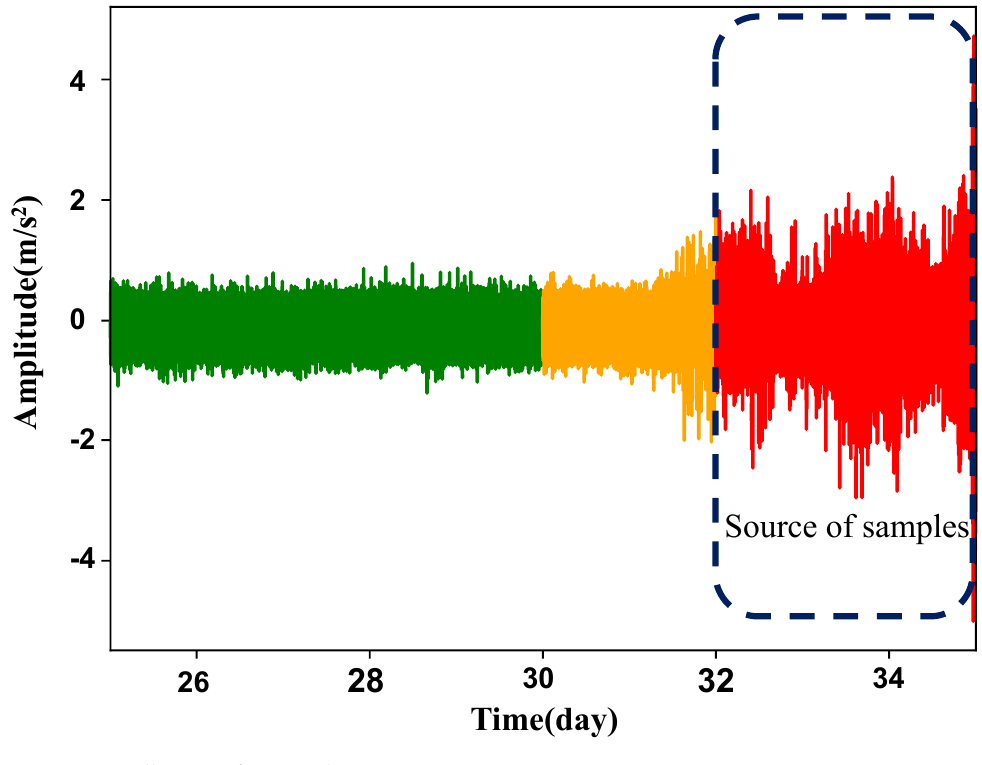
Figure 13. Collection of NASA datasets. Table 7. Data description.